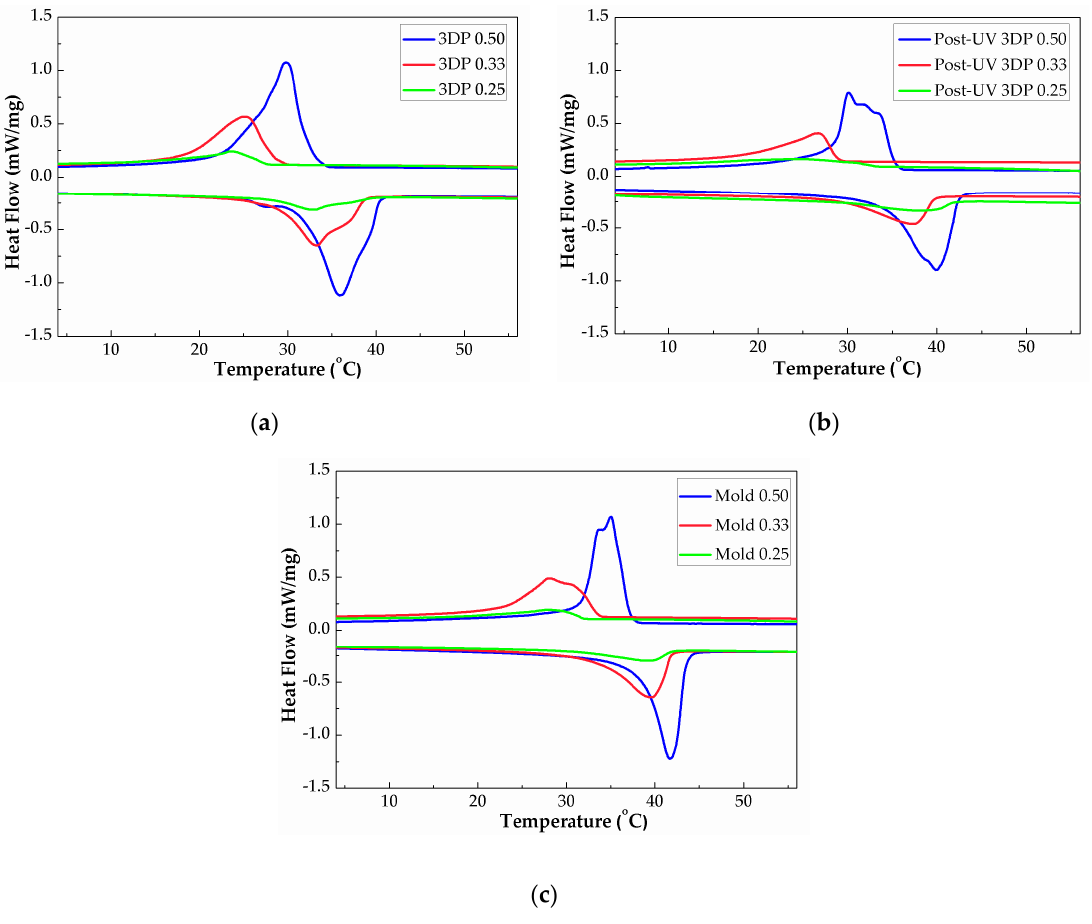
Figure 9. Differential Scanning Calorimetry (DSC) curves of thermal energy storage crystalline P(SA-DMAA) gels prepared from 3D printing ( a ), 3D printing with post-UV curing treatment ( b ), and curing with conventional UV mold ( c ). Table 2. Phase transition temperatures and phase change enthalpies measured by DSC for P(SA-DMAA) gels.